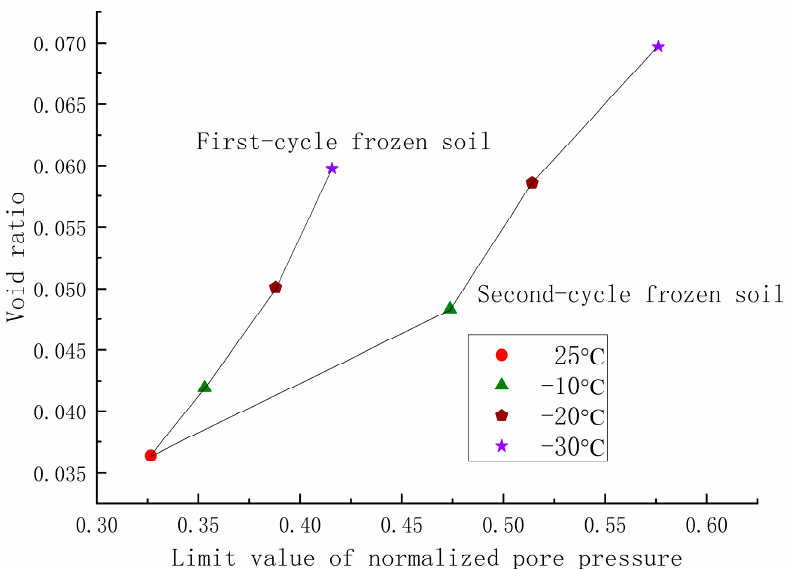
Figure 20. Void ratio vs. limit value of normalized pore pressure curve.